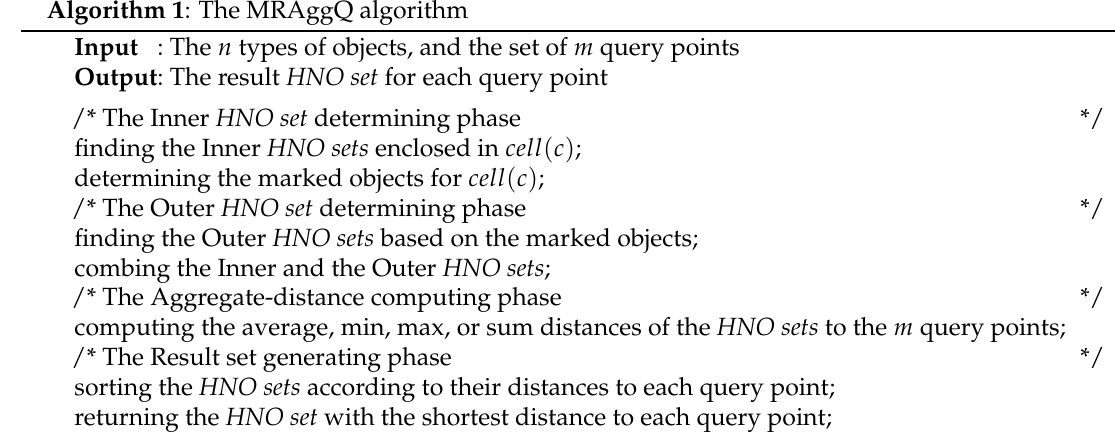
Algorithm 1 : The MRAggQ